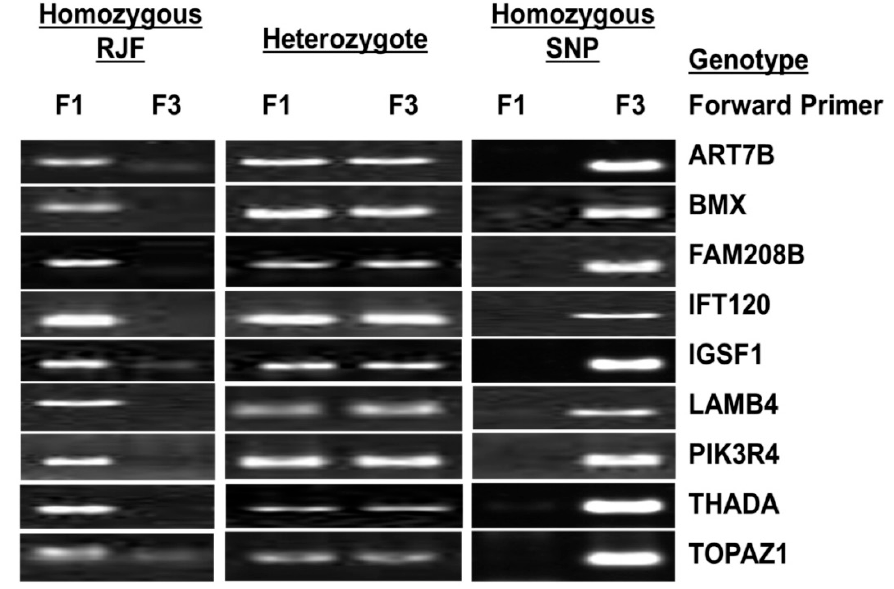
Figure 2. Nine candidate markers and different genotypes shown by allele-specific PCR in a larger population of AR and AP chicken lines. RJF: Red Jungle Fowl